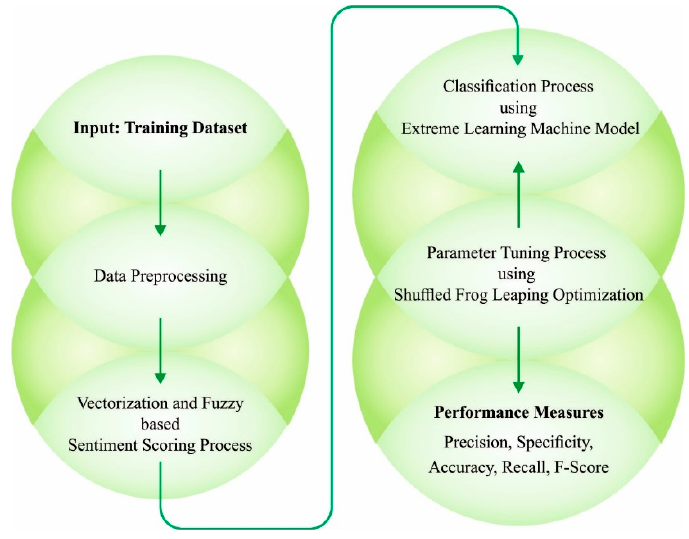
Figure 1. Working process of CLBEDC-SND